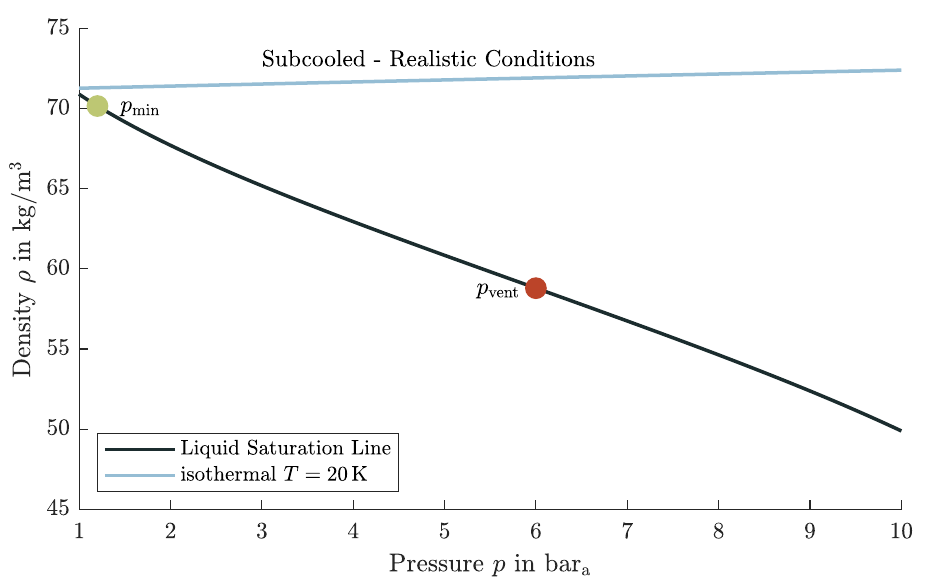
Figure 7. Density of LH2 over pressure for short term storage; difference between saturated and subcooled